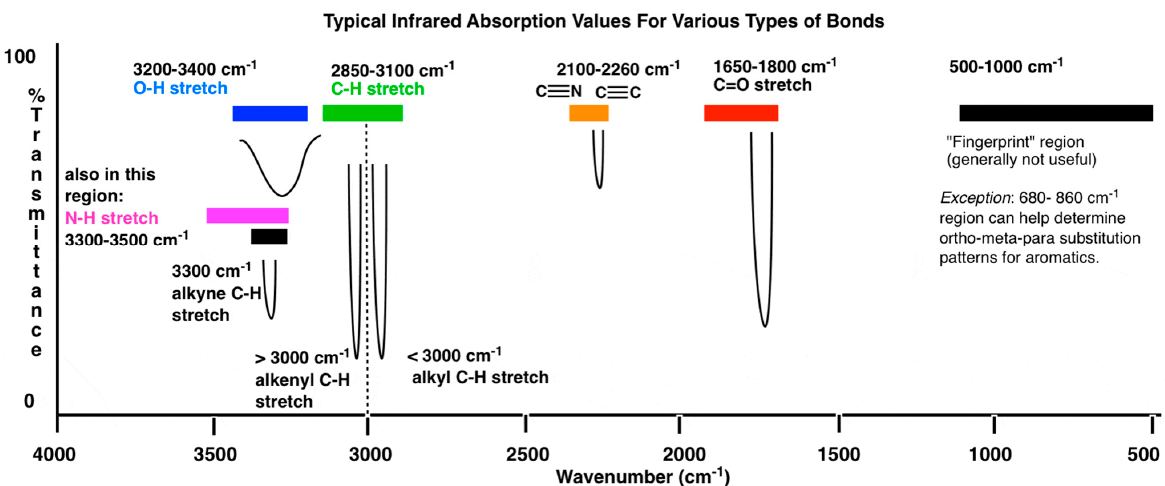
Figure 1. The locations of some major absorption bands in the mid-infrared region. Reproduced from Master Organic Chemistry (https://www.masterorganicchemistry.com/2016/11/23/quick_analysis_of_ir_spectra/) (accessed on 6 January 2022), with kind permission from James Ashenhurst. Table 1. Mid-infrared absorption bands for a range of bonds important for food analysis. Compound/Functional Bond Wavenumbers (cm − 1 ) 1 Group O-H stretch